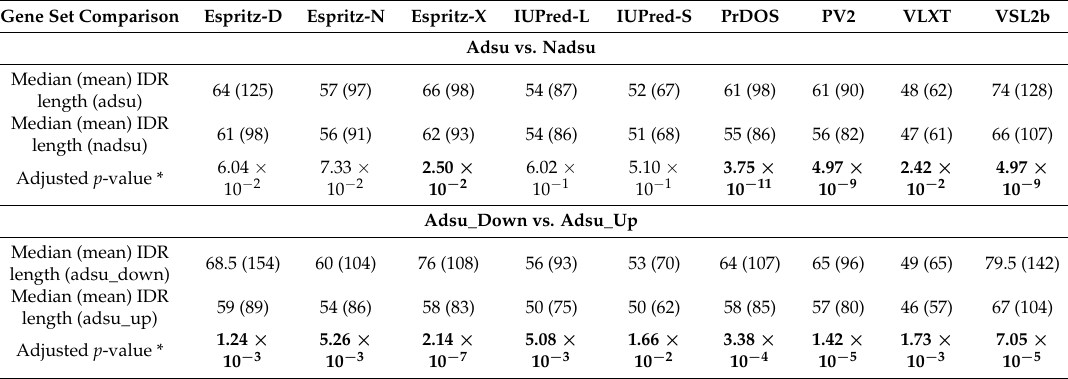
Table 2. Intrinsically disordered regions tend to be longer in proteins encoded by down-regulated genes in lymphoma cells upon adherence to stromal cells.